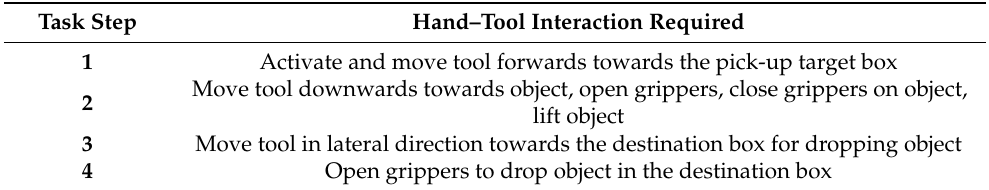
Table 1. Verbal description of each of the four task steps. The colored boxes correspond to task steps as visualized in the spatiotemporal profiles shown in the Results